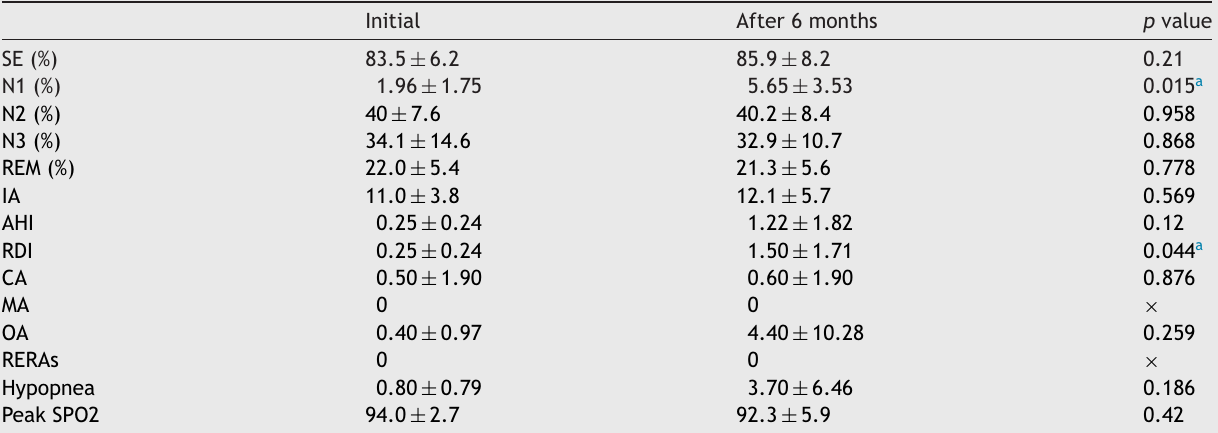
Results of the initial polysomnography and after 6 months for the snoring